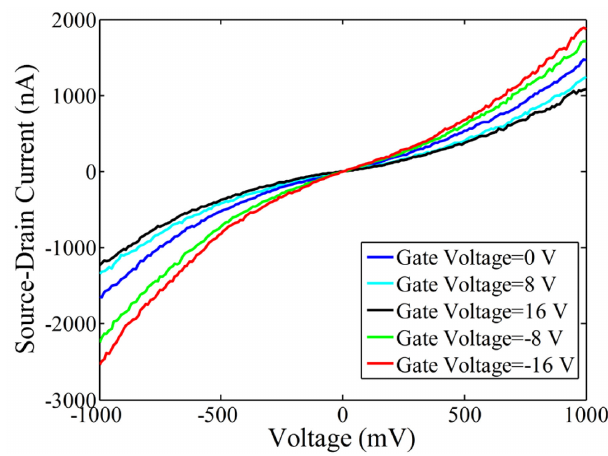
Figure 13. SWCNT-graphene FET electrical characteristics.